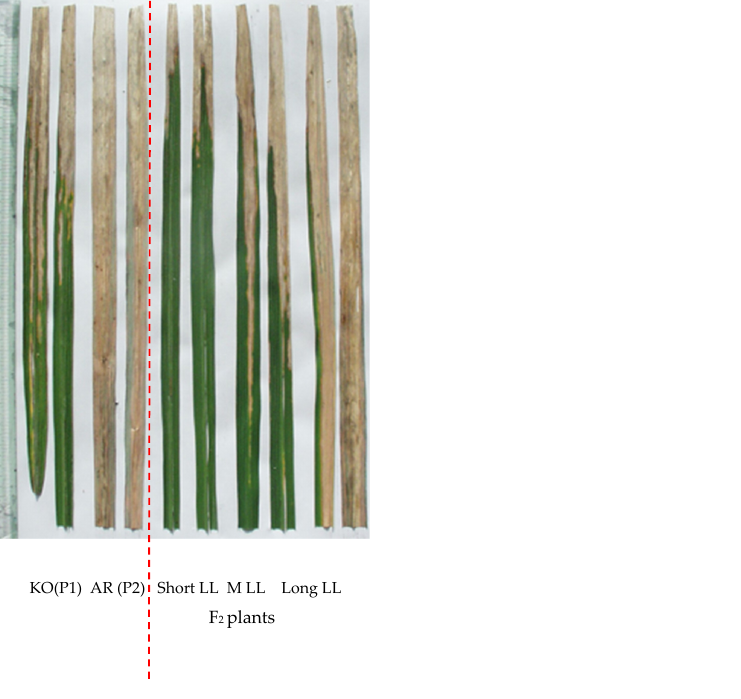
Figure 1. Morphology of lesion length at 18 days for KO (parent 1 (P1)) and AR (parent 2 (P2)) and its F 2 progenies inoculated to Race II Xoo (strain T7147) showing short lesion length, moderate lesion length (MLL), and long lesion